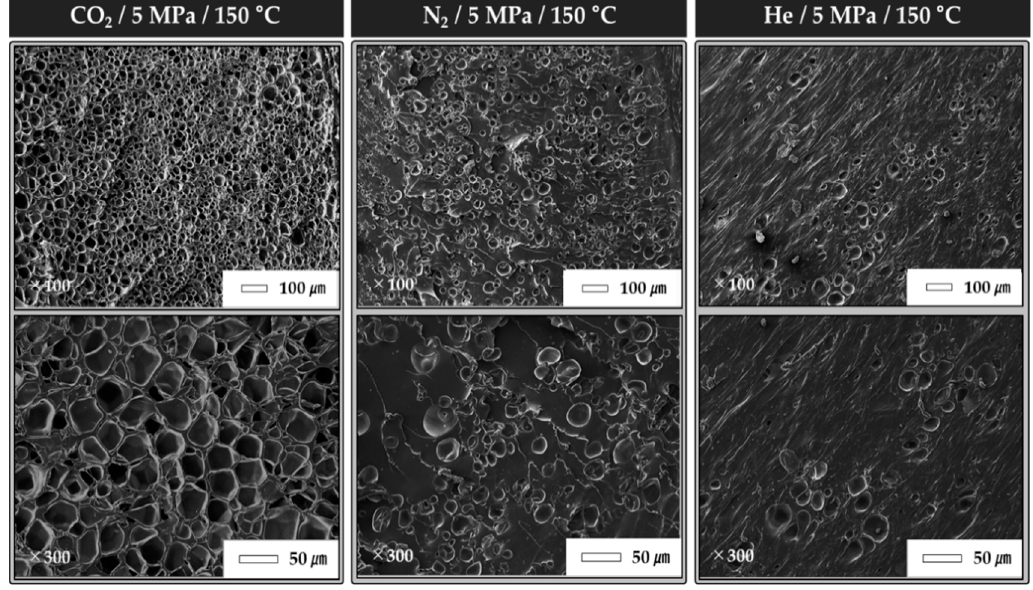
Figure 4. Cross-sectional SEM images of TPU specimens for different gas species. Table 6. Foaming properties of thermoplastic polyurethanes (TPU) according to gas species. Experimental